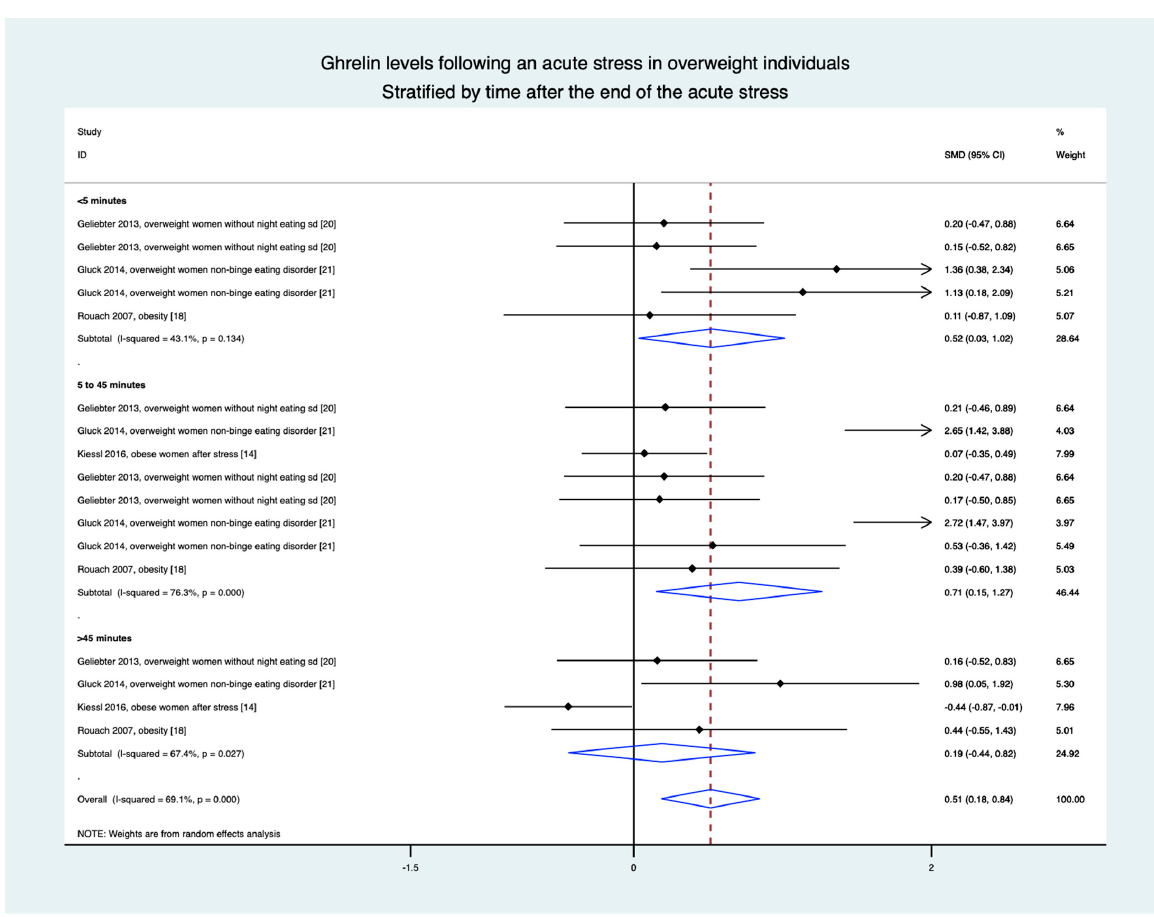
Figure 5. Meta-analysis of ghrelin levels after acute stress compared to baseline levels in the overweight population, stratified by time after the initiation of the acute stress intervention.